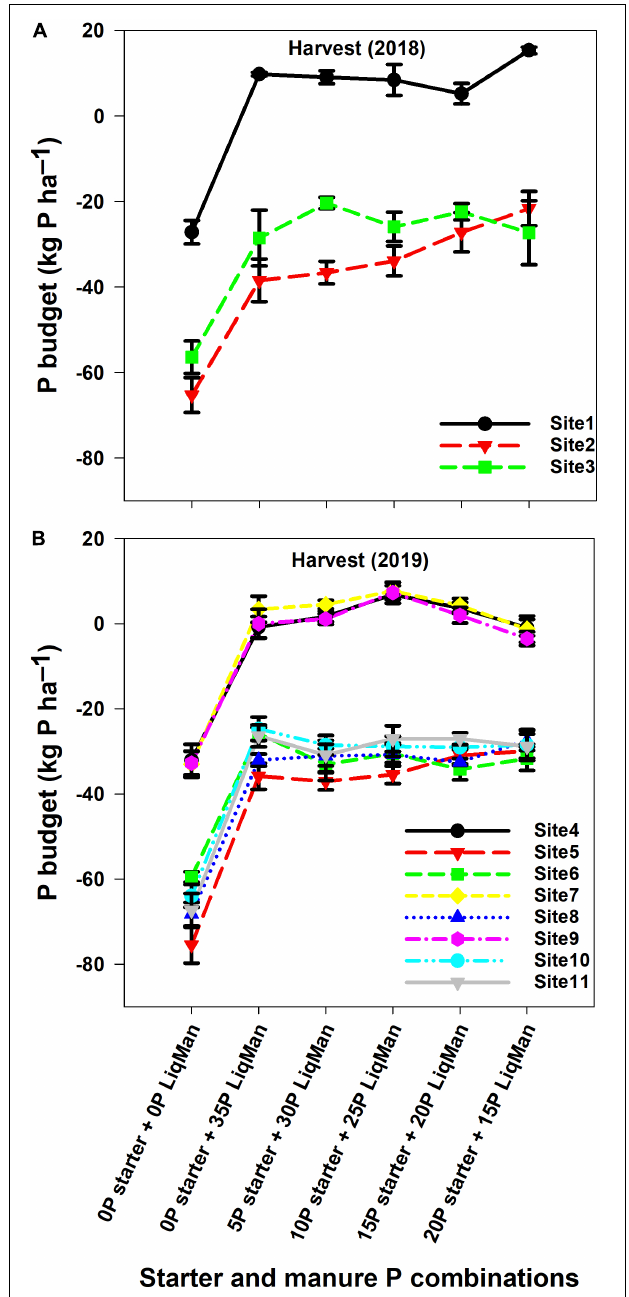
FIGURE 8 | P budget at harvest with application of starter P rates and dairy manure across 11 sites [2018 (A) and 2019 (B) ] in the Fraser Valley, BC. Dairy manure was applied at 6-leaf stage. Error bars represent standard deviations of the